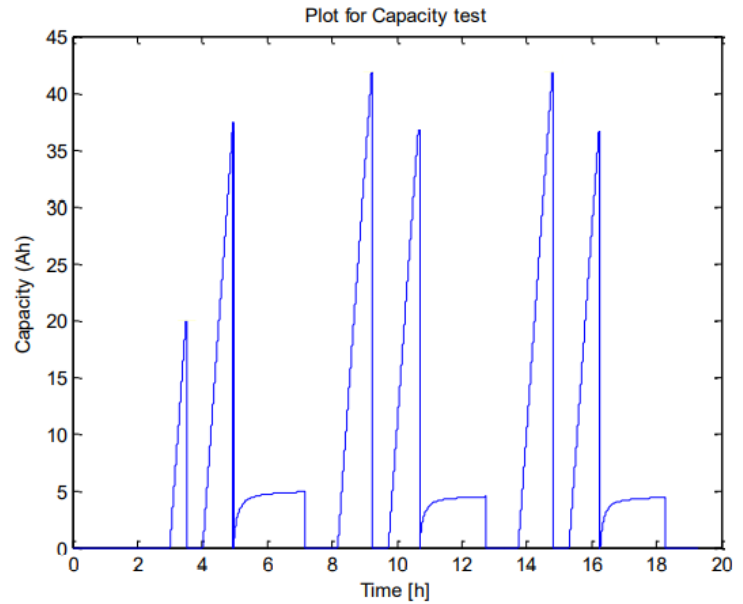
Figure 11. Plot for capacity testing.